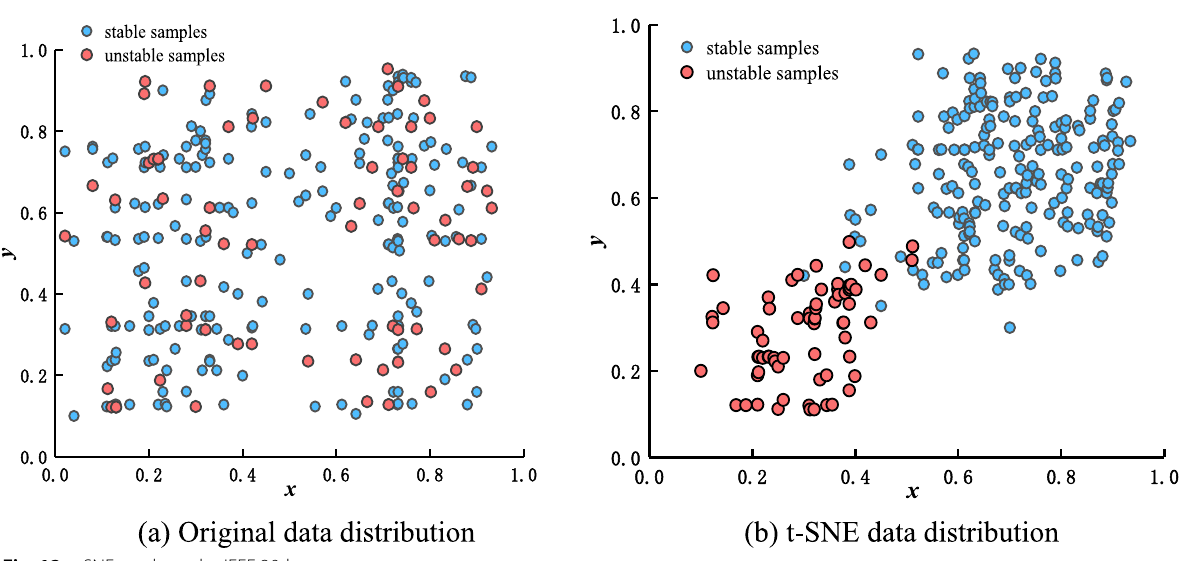
Fig. 12 t-SNE result on the IEEE 39-bus system